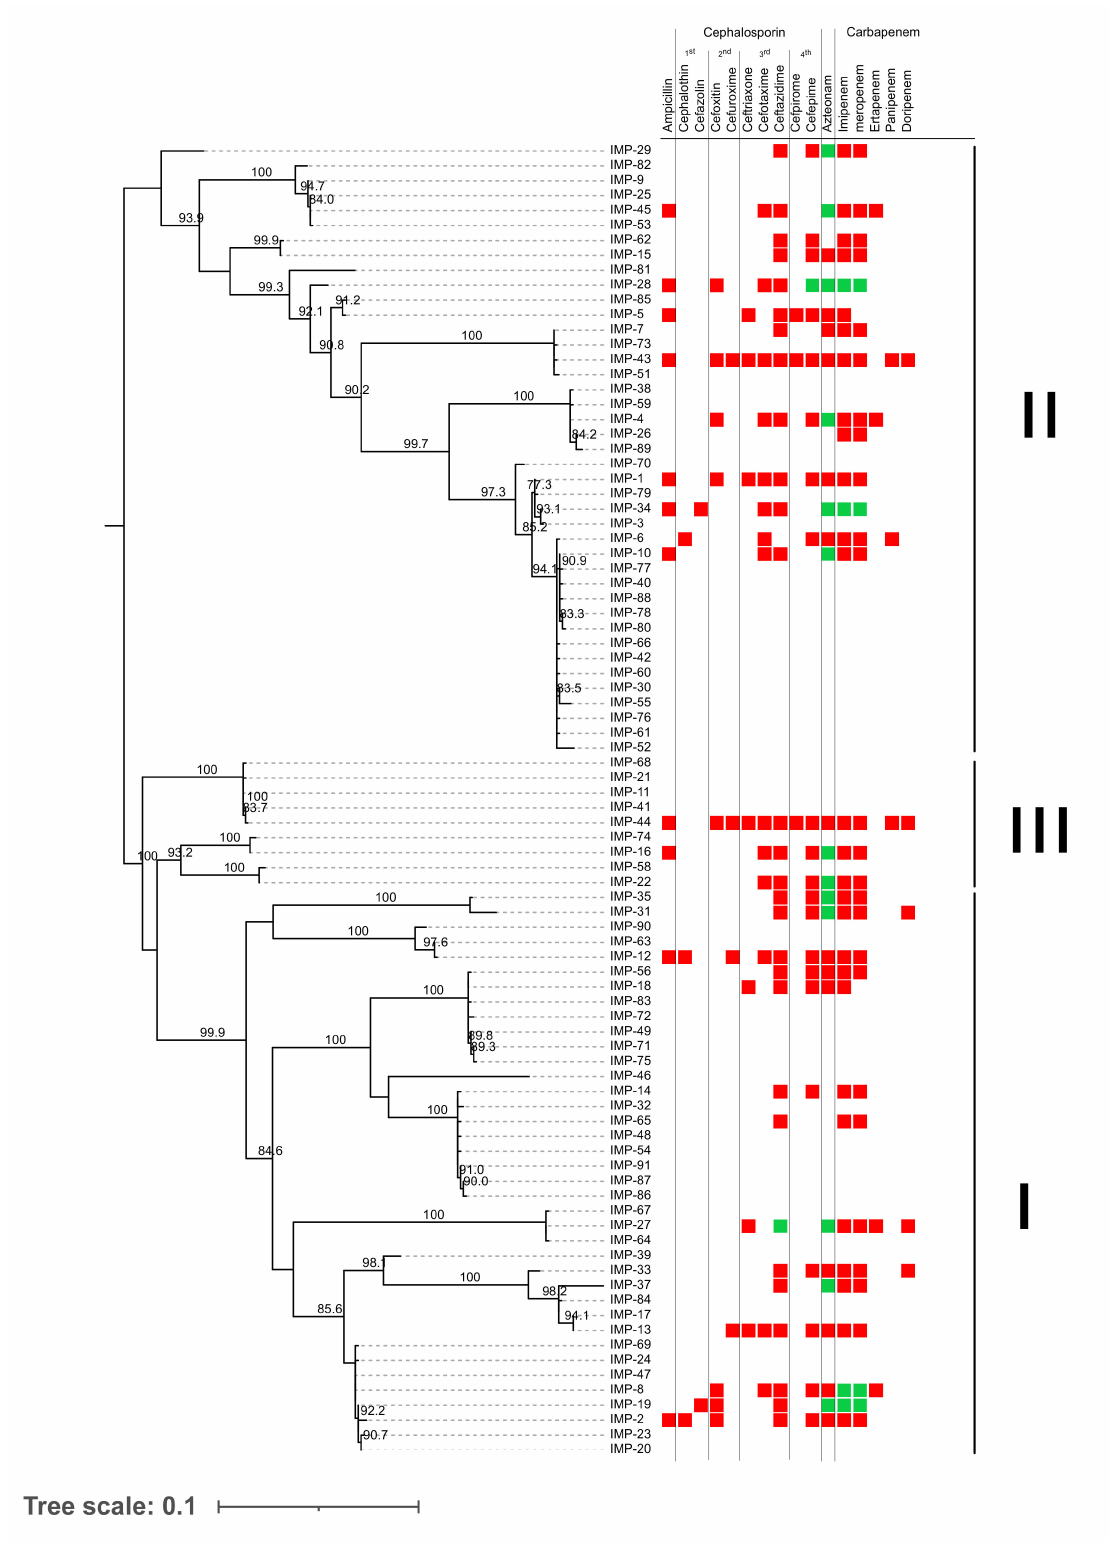
Figure 3. Phylogenetic relationship of bla IMP genes. An unrooted maximum likelihood phyloge- netic tree constructed using nucleotide sequences of 88 bla IMP genes with 1000 bootstrap supports was visualised together with antibiotic susceptibility profile of 32 variants of the bla IMP gene. Red squares indicated “resistant” while green squares indicated “susceptible”. IMP-N is used to repre- sent